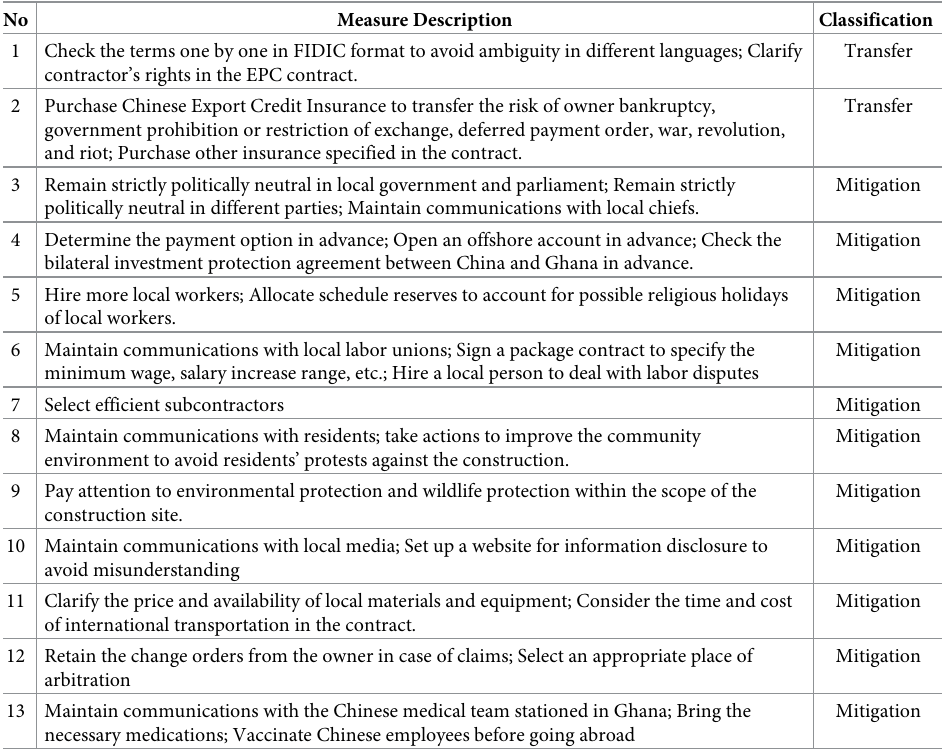
Table 8. List of response measures for the target project.